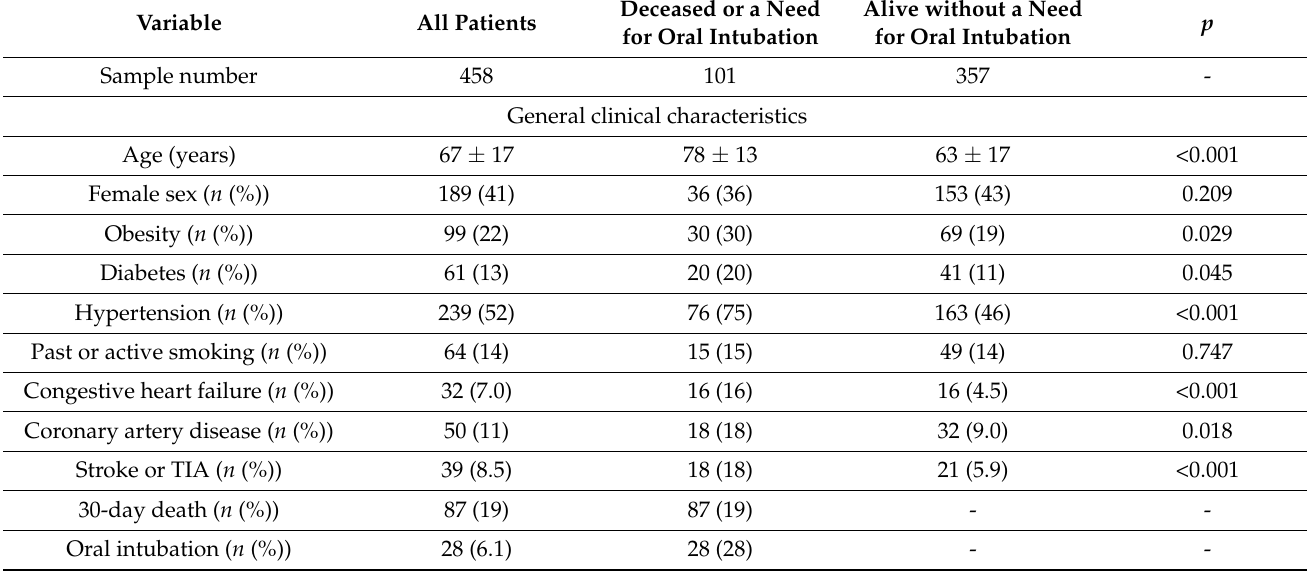
Table 2. Variables summary and comparison according to the composite outcome occurrence after follow-up at 30 days in the entire cohort of patients from the hub hospital.